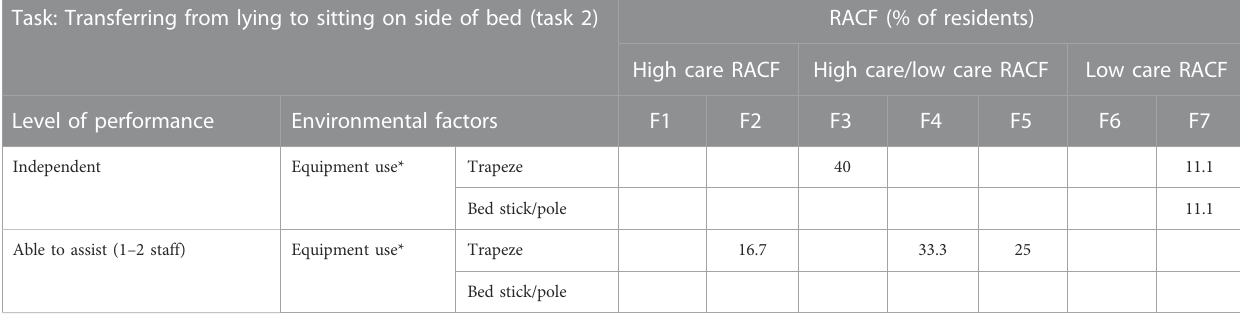
TABLE 3 Summary of the relationship between level of performance with transferring from lying to sitting on side of bed (Task 2) and key environmental factors. Task: Transferring from lying to sitting on side of bed (task